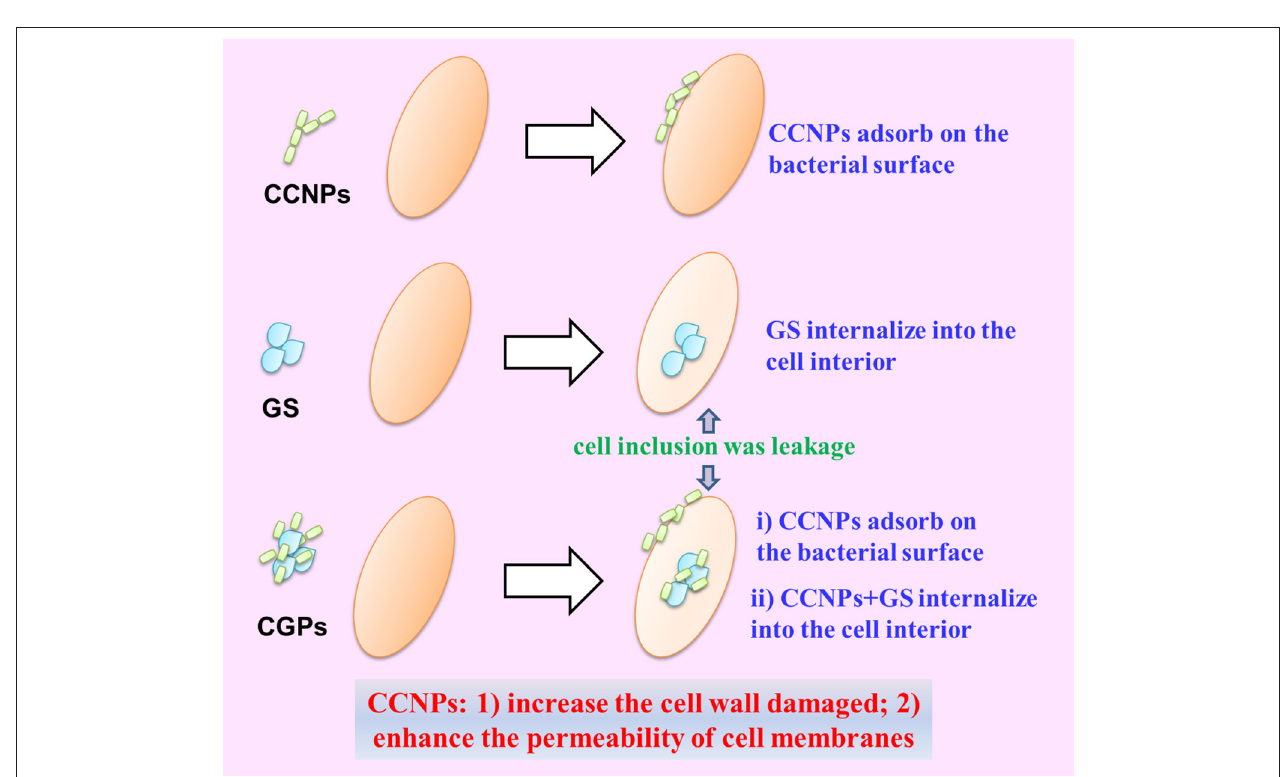
FIGURE 9 | Schematic diagram of the synergistic antibacterial mechanism between NP aggregates and drug.